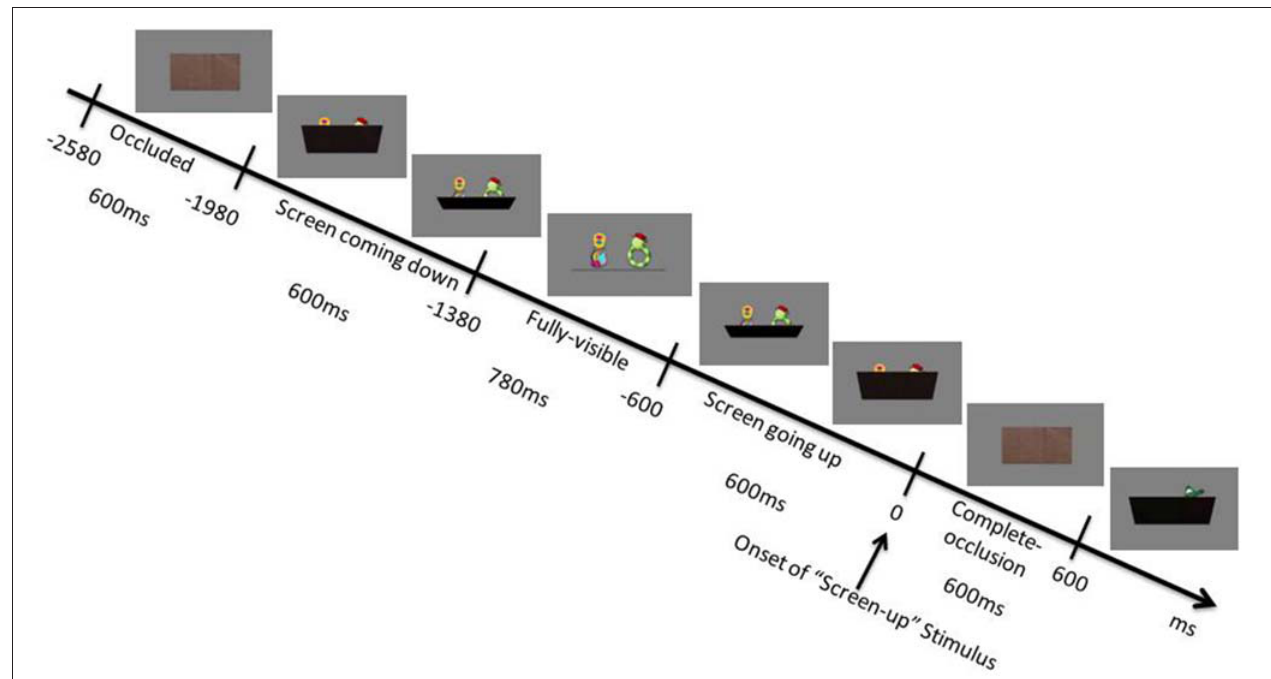
FIGURE 1 | A schematic presentation of the trial